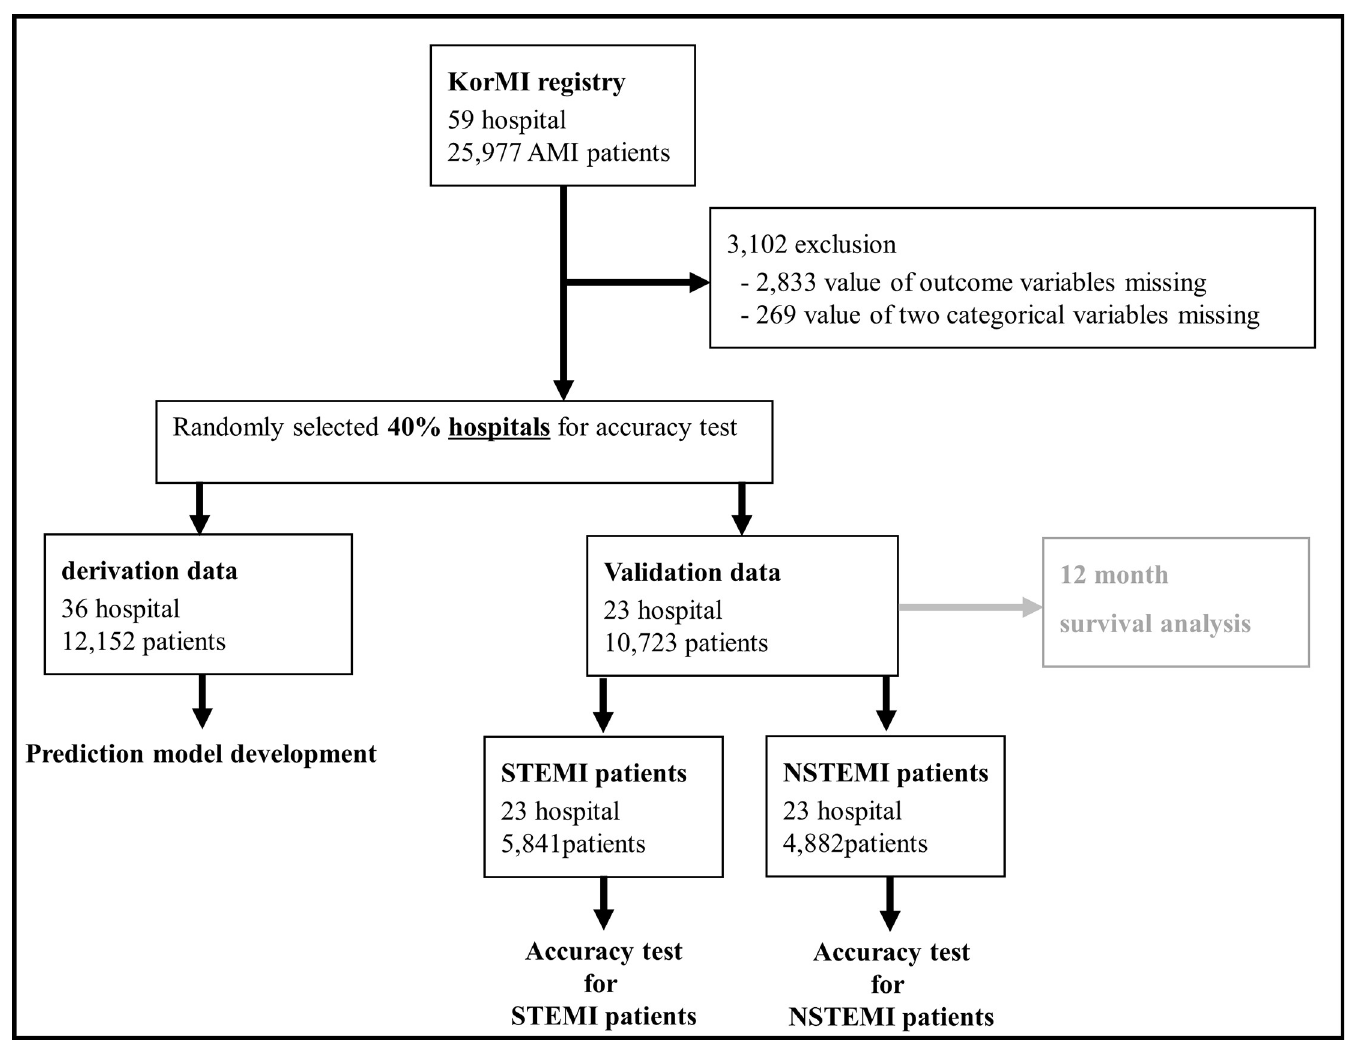
Fig 1. Study flow